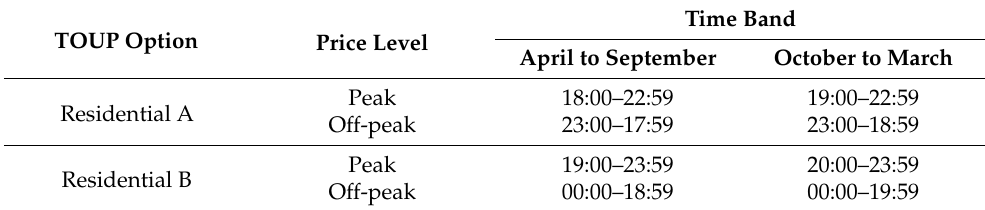
Table 3. Options of time bands and price levels for residential tariffs.